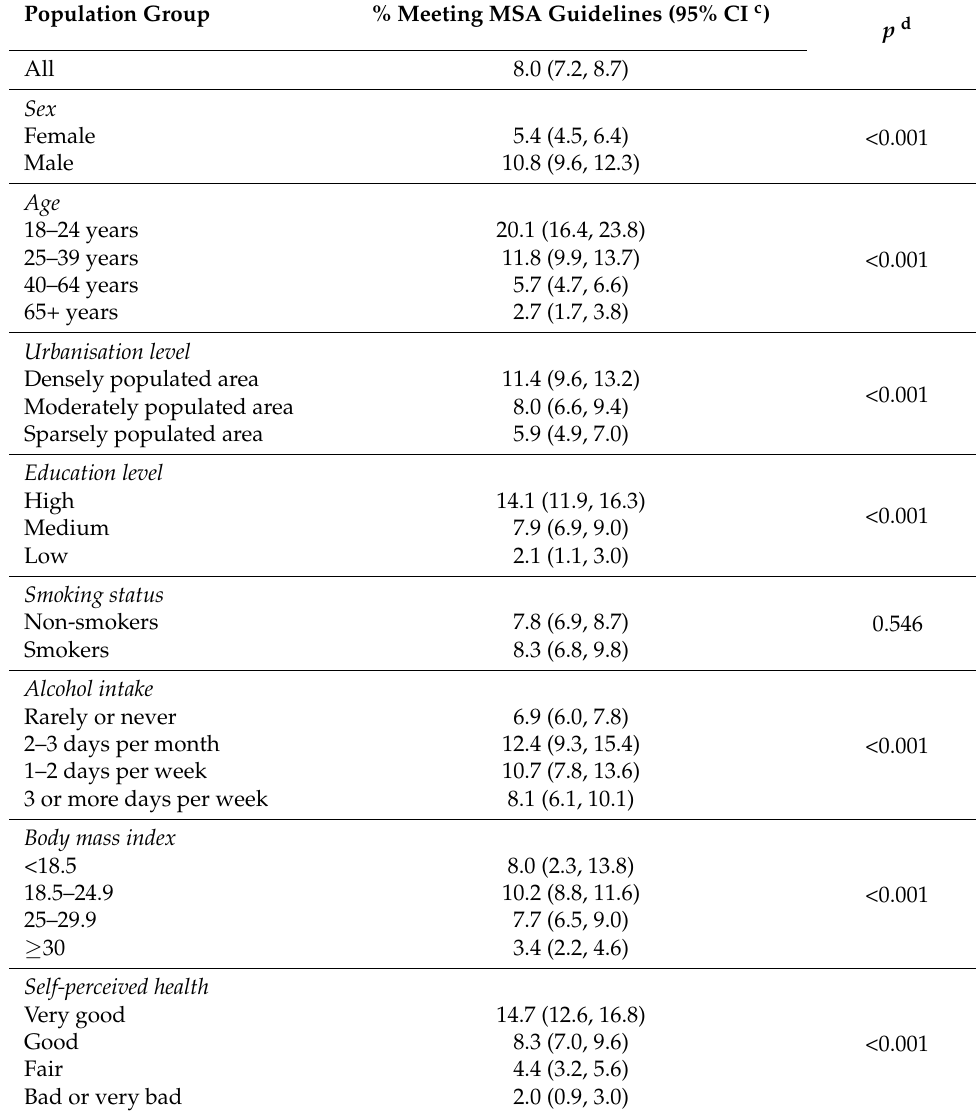
Table 2. Weighted a prevalence of meeting the muscle-strengthening activity (MSA) guidelines b across different population